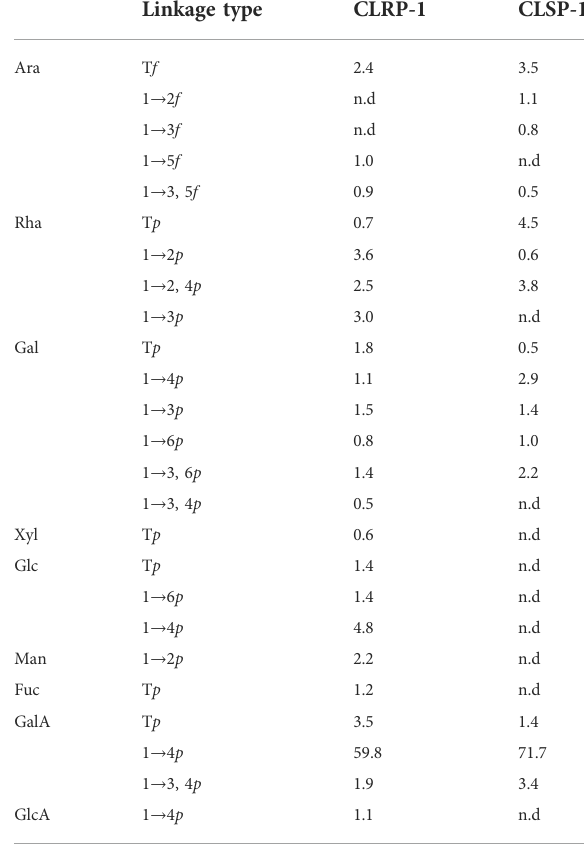
TABLE 2 The linkage types (mol%) of the monosaccharides present in the fractions CLRP-1 and CLSP-1 by GC-MS after